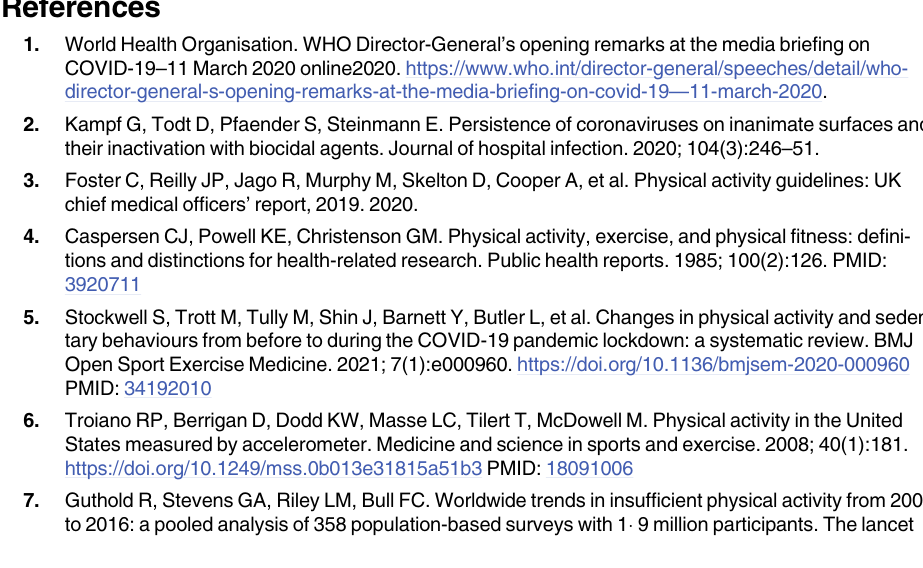
S2 Table. Methodological quality. S3 Table. Physical activity studies (n = 44). S4 Table. Intensity specific physical activity studies (n = 17). S5 Table. Exercise studies (n = 12). S6 Table. Sedentary behaviour studies (n =